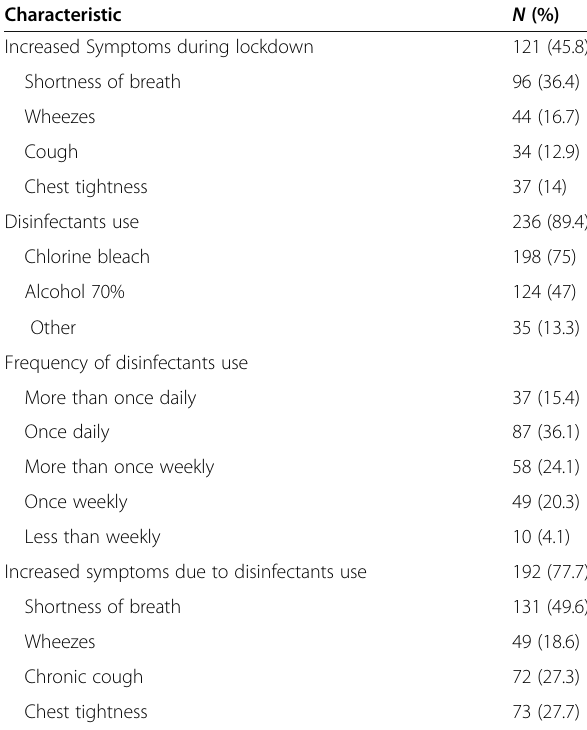
Table 2 Characteristics of the study participants during